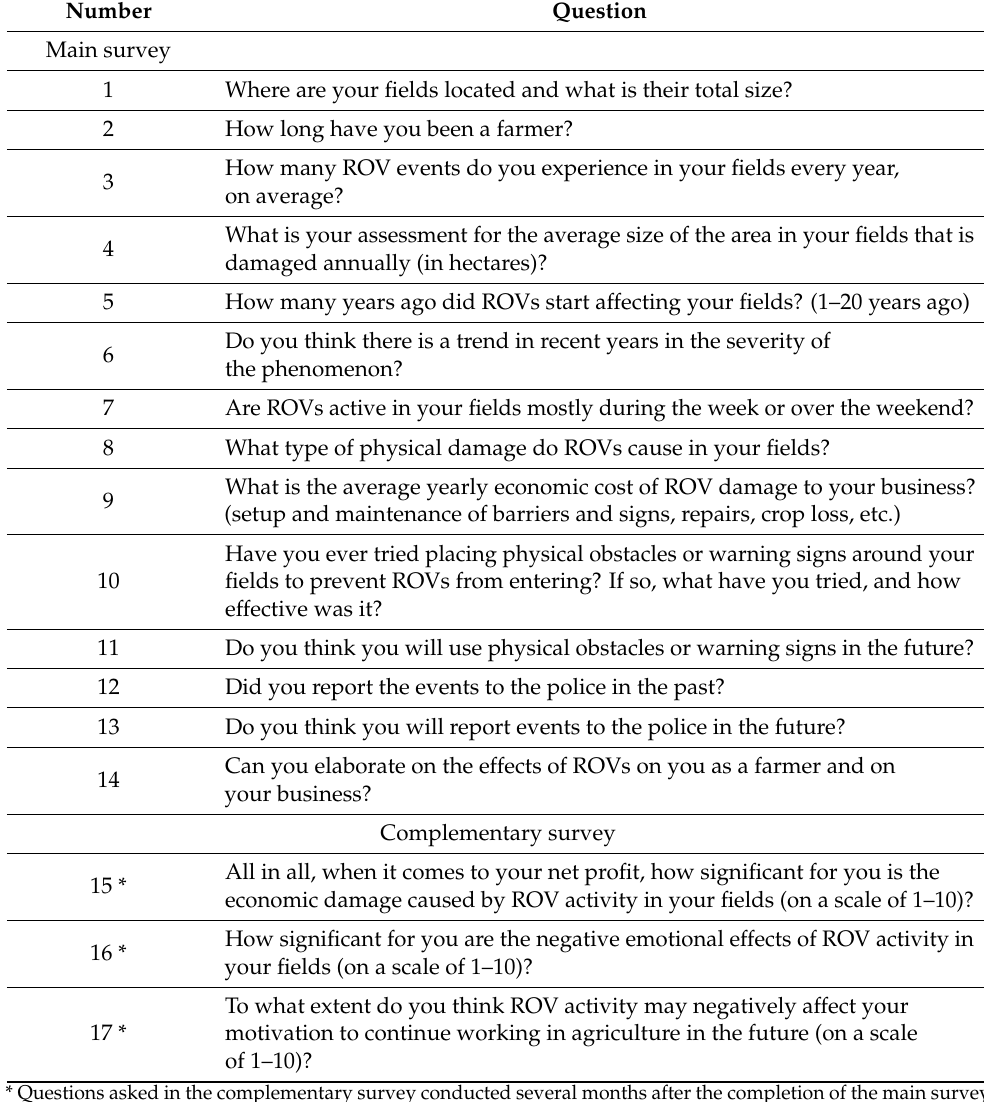
Table 1. Questions that guided the in-depth interviews with the